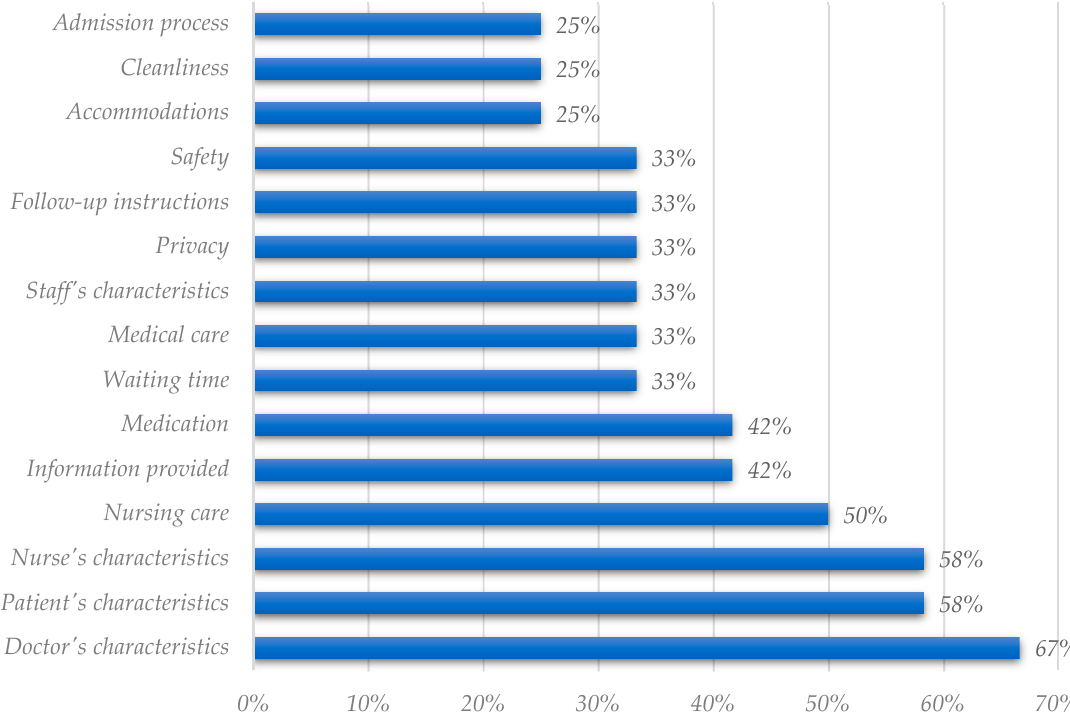
Figure 6. Analysis of the most utilized factors in the literature (willingness to recommend analysis).